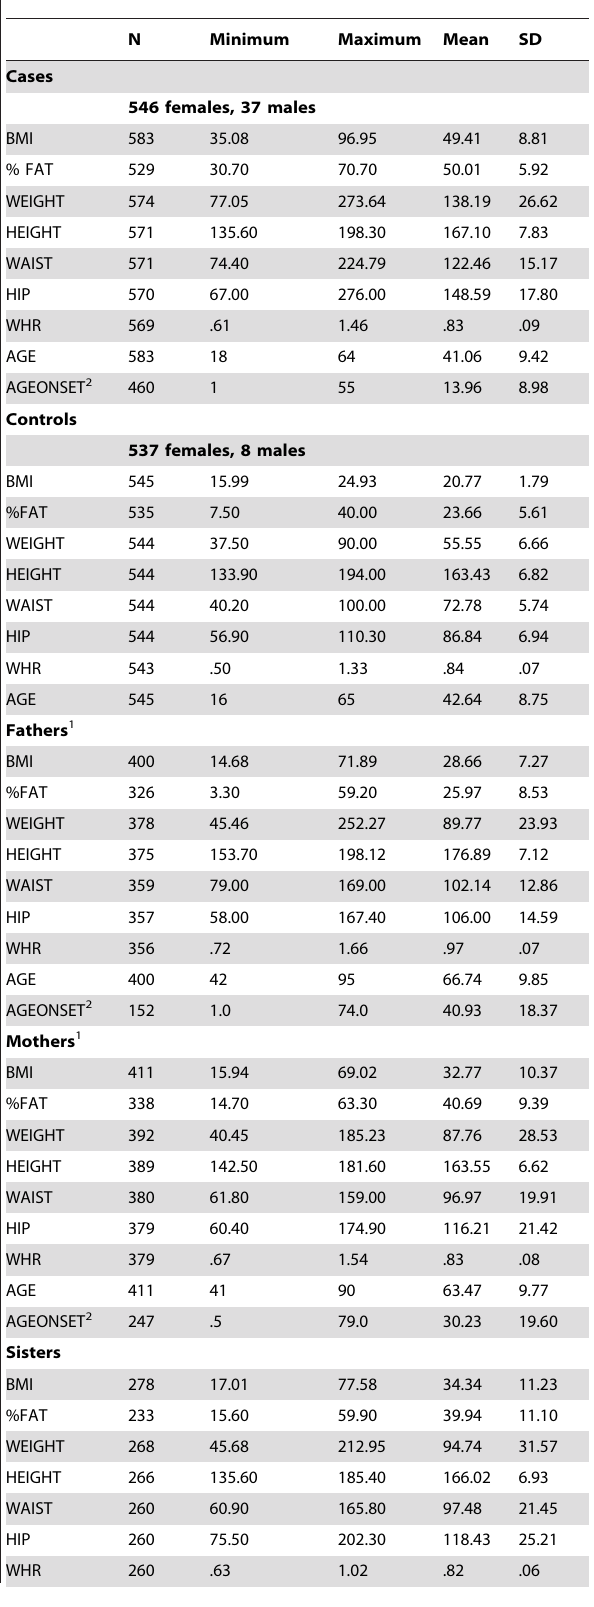
Table 2. Sample characteristics of 2,256 samples in the candidate SNP